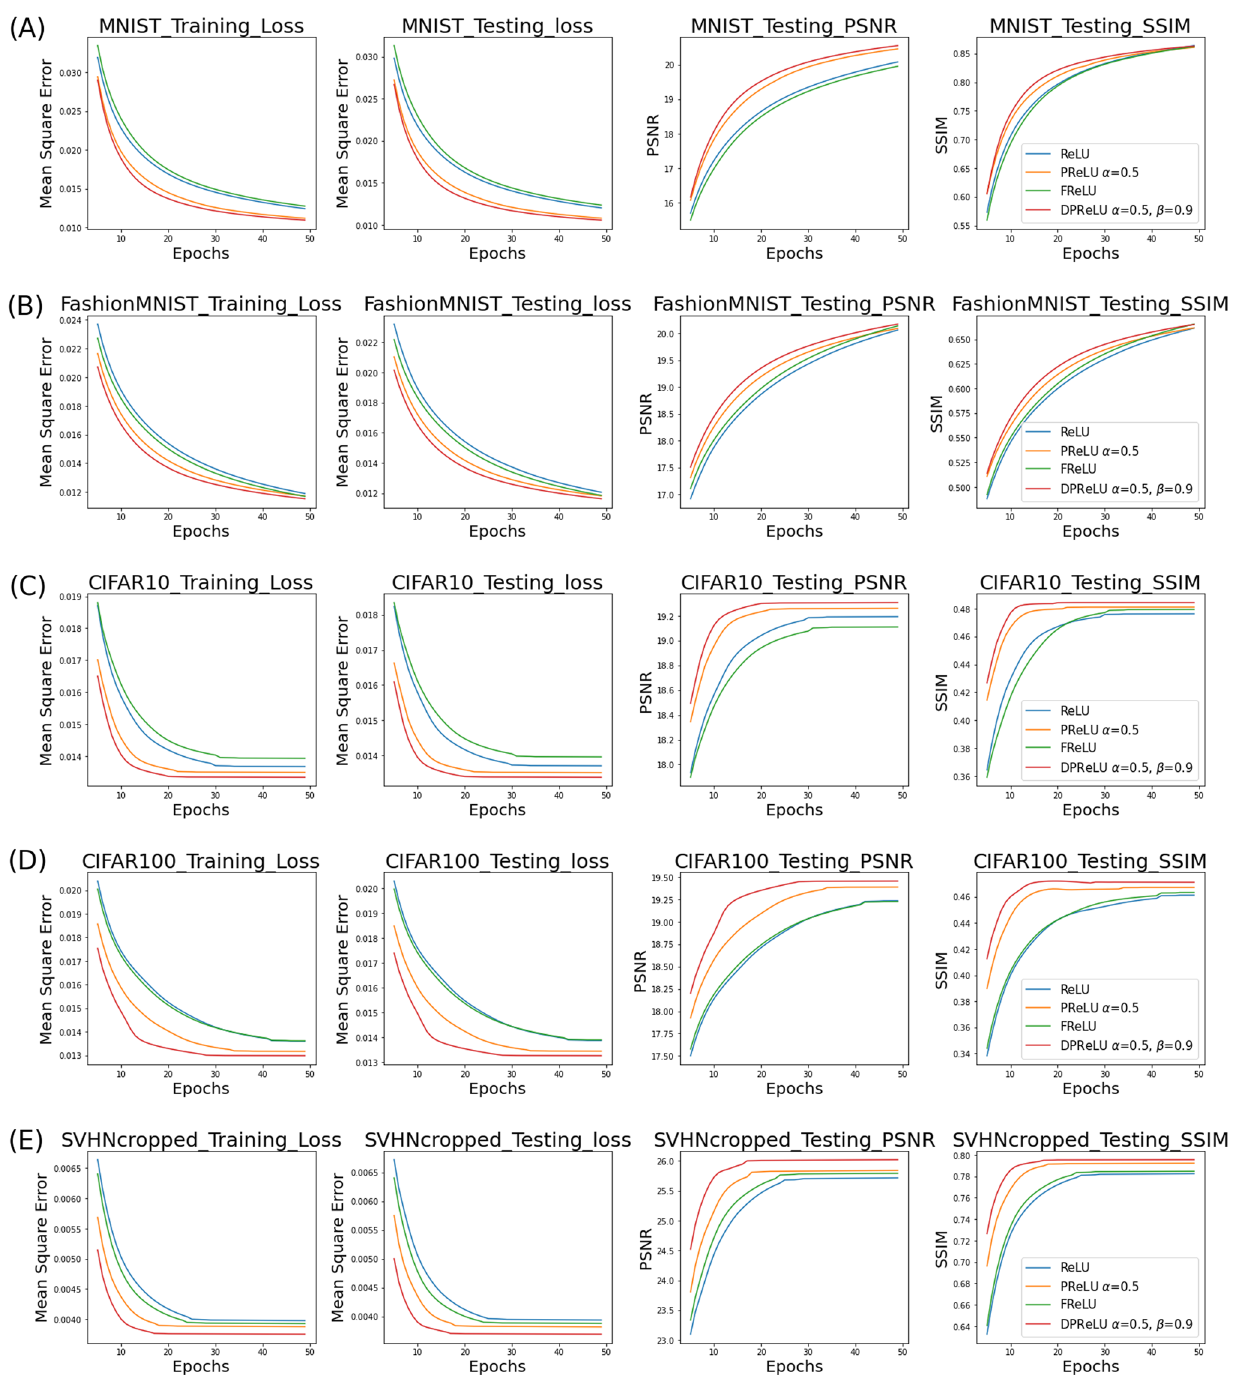
Fig. 3 Performance of the autoencoder models using each activation with corresponding weight initialization from 5th to 50th epoch on various image datasets. ( 𝛼 and 𝛽 represent the initial values that performed the best in each model, which changed dynamically during